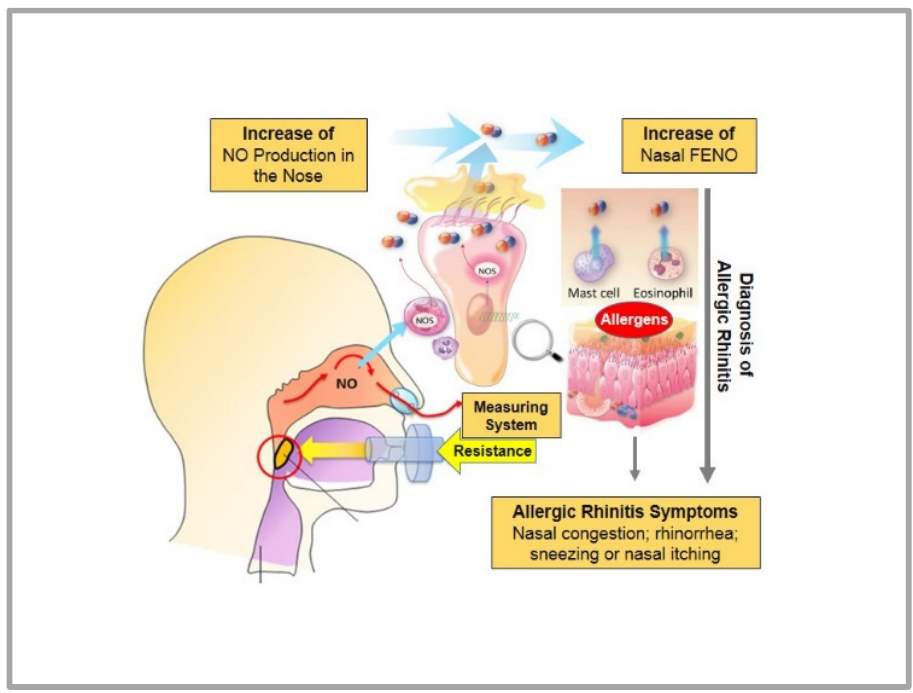
Figure 3. Principle of nasal FENO measurement in subjects with AR [3]. AR: allergic rhinitis; FENO: fractional exhaled nitric oxide; NOS: nitric oxide synthase.